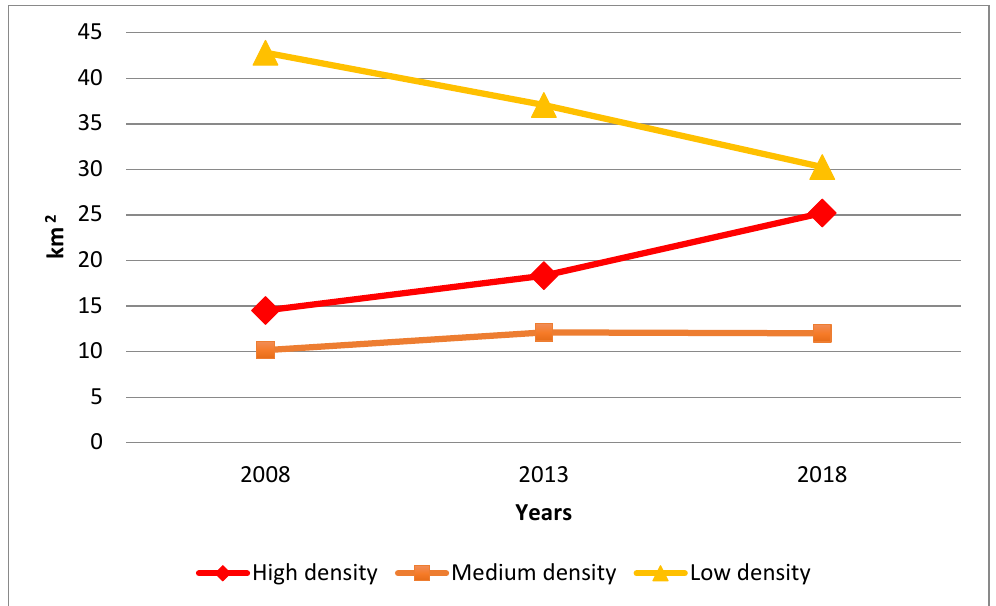
Fig. 9. Trend in residential density changes for 2008, 2013 and 2018 (Developed by the authors,